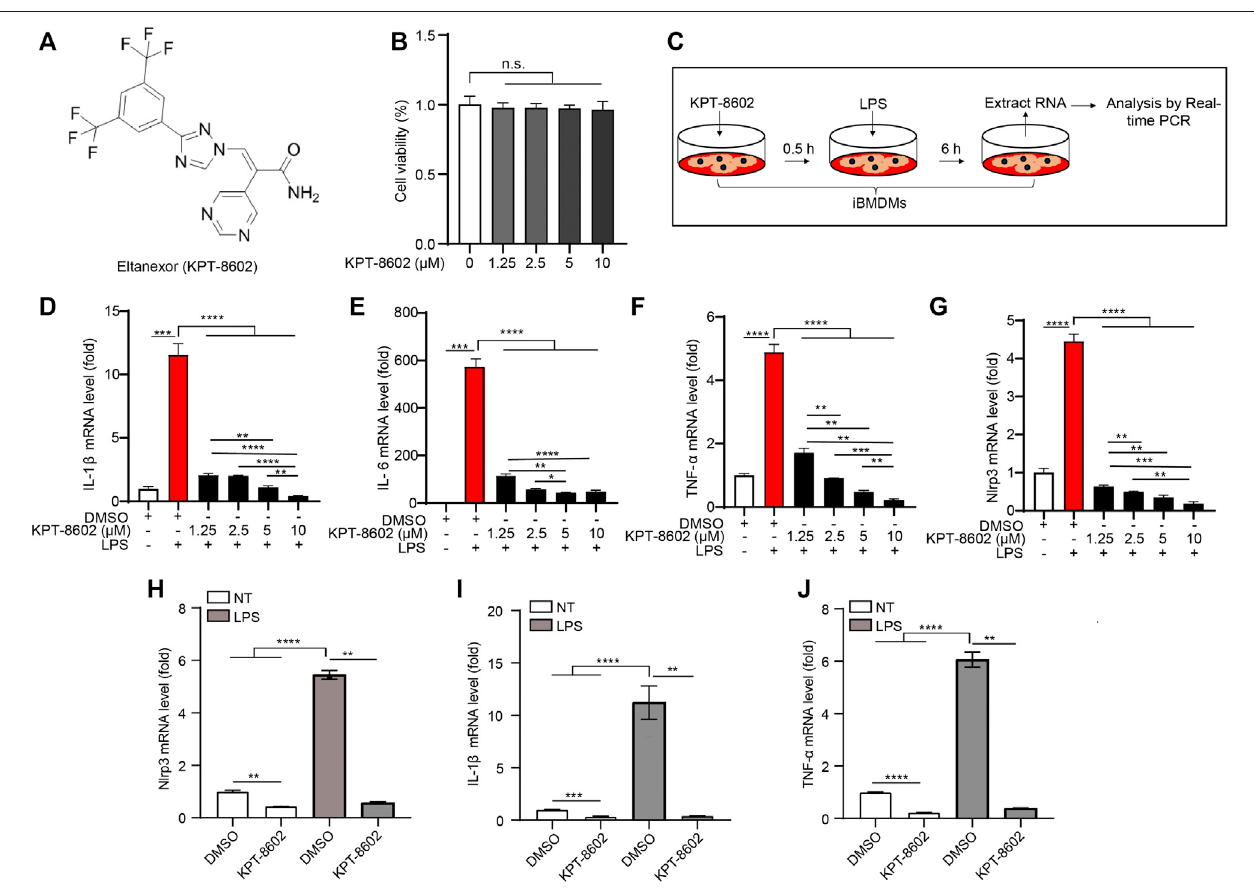
FIGURE1| KPT-8602inhibitsLPS-inducedhighexpressionofpro-in fl ammatorycytokinesinmacrophages. (A) Structure ofKPT-8602. (B) iBMDMsweretreated with various doses of KPT-8602 for 6 h, and cell viability was assessed by the CCK-8 assay kit. (C) Working model of LPS-induced in fl ammation. (D – G) iBMDMs were pretreated with KPT-8602 at different concentrations and stimulated with LPS for 6 h, and then the mRNA levels of IL-1 β (D) , IL-6 (E) , TNF- α (F) , and Nlrp3 (G) were analyzedbyreal-timePCR. (H – J) Primaryperitonealmacrophages(PMs)pretreatedwithKPT-8602(5 μ M)weretreatedwithLPSfor6h,andthenthemRNAlevels ofNlrp3 (H) ,IL-1 β (I) ,andTNF- α (J) wereanalyzedbyreal-timePCR.(**indicates p < 0.01,***indicates p < 0.001,****indicates p < 0.0001byone-wayANOVA).n.s.no signi fi cant, NT, no